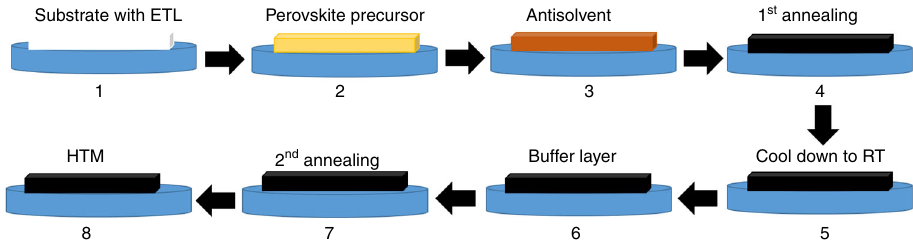
Fig. 1 Scheme of our method for treating perovskite fi lms by spin-coating of different organic ammonium salts (EAI, IAI, and GuaI) and consecutive